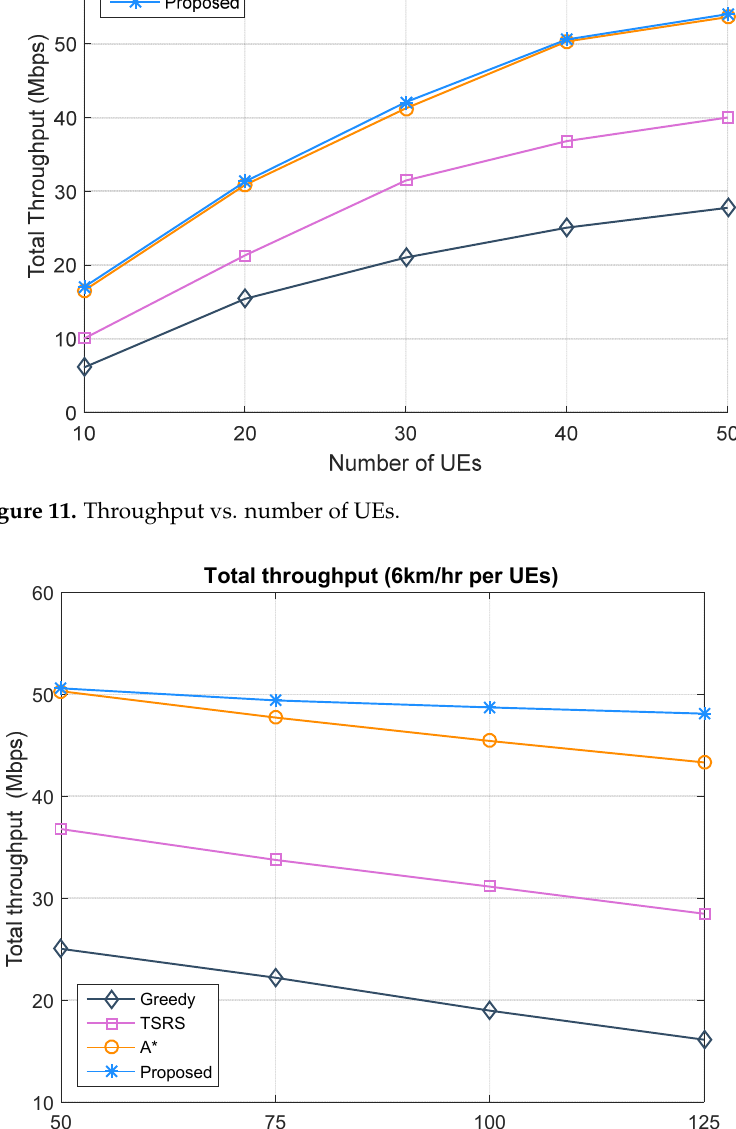
Figure 13. Throughput vs. D2D link length. We now turn our attention to another vital performance index—delay. Figure 14 shows that the average delay increases as the number of UEs increases. The proposed approach considers channel conditions by including the delay factor in its definition of utility. As a result, there is a lower increase in the delay as the number of UEs increases. Figure 15 shows the results of delay when UEs are on the move. Greedy and TSRS cannot react quickly enough and therefore have more chances of picking up inferior paths. On the other hand, A* and the proposed approach can adapt themselves better to the top- ological change. There is a slight performance difference between A* and the proposed approach. The A* algorithm recalculates a new path in response to topological change. However, as the moving speed increases, A* may fail to catch up with the changes. On the other hand, the BICA* search endows the proposed approach with the rapid reaction capability to topological changes, as expected.